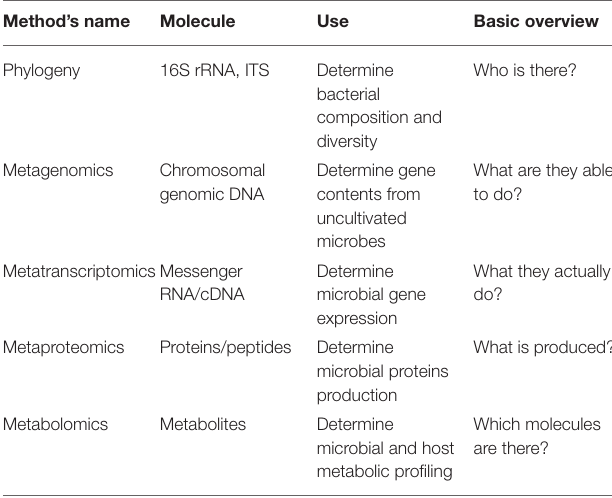
TABLE 1 | Analytical methods to study the microbiome [adapted from Lepage et al. (38), with